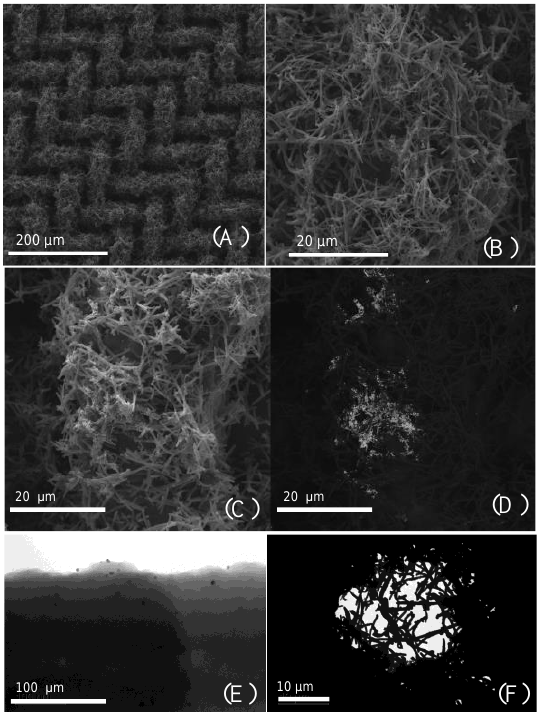
Figure 2. Representative SEM images from the steel mesh coverage: ( A , B ) closer approximation of a wire mesh, ( C ) the wire-mesh image of secondary electrons of the hybrid PPy/AuNPs, and ( D ) the SEM with backscattered electrons. ( E , F ) TEM representative images from a single nanotube and a small gap in between the steel mash, respectively.